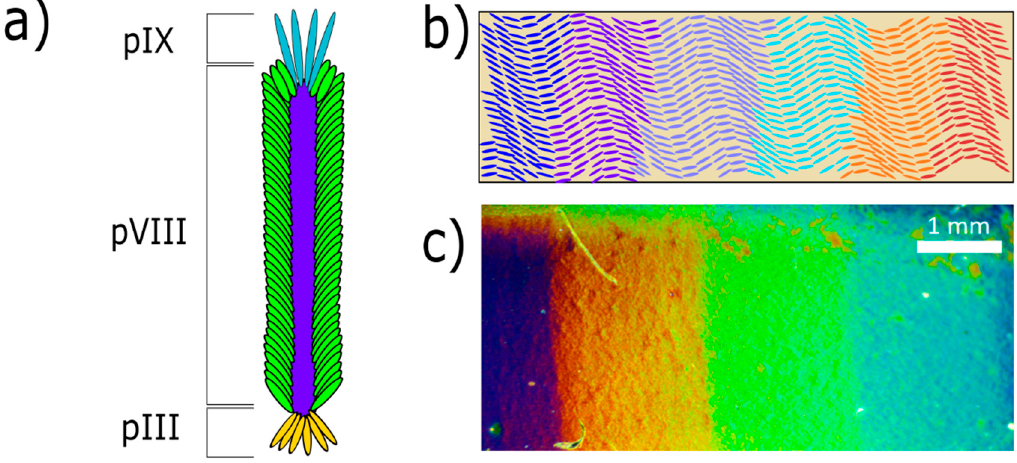
Figure 1. ( a ) A schematic of an individual M13 bacteriophage featuring the filamentous shape with a diameter of approximately 6 nm and a length of 900 nm. An individual phage is coated with approximately 2700 copies of the minor pVIII coat protein, giving the phage a slightly negative surface charge, while fewer pIX and pIII proteins are situated at the head and tail, respectively [22,23]. ( b ) A schematic of a phage litmus with bundles of phage assembled into smectic helicoidal nanofilament (SHN) structures on a substrate. Color change is achieved by the shrinking and swelling of the SHN bundles in response to different compounds binding to the coat proteins. ( c ) An image of a phage litmus fabricated as a pulling method reference sample in this study.